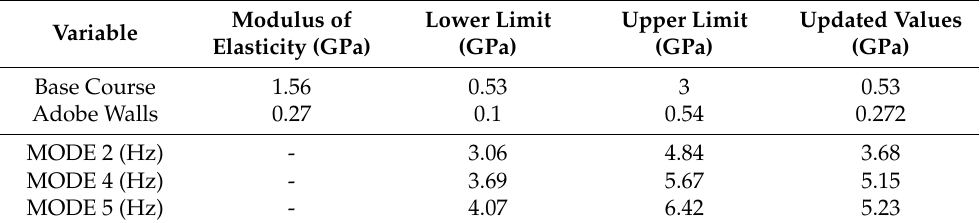
Table 5. Upper and lower limit values for calibration for MODEL_1, with the corresponding frequen- cies, for the selected